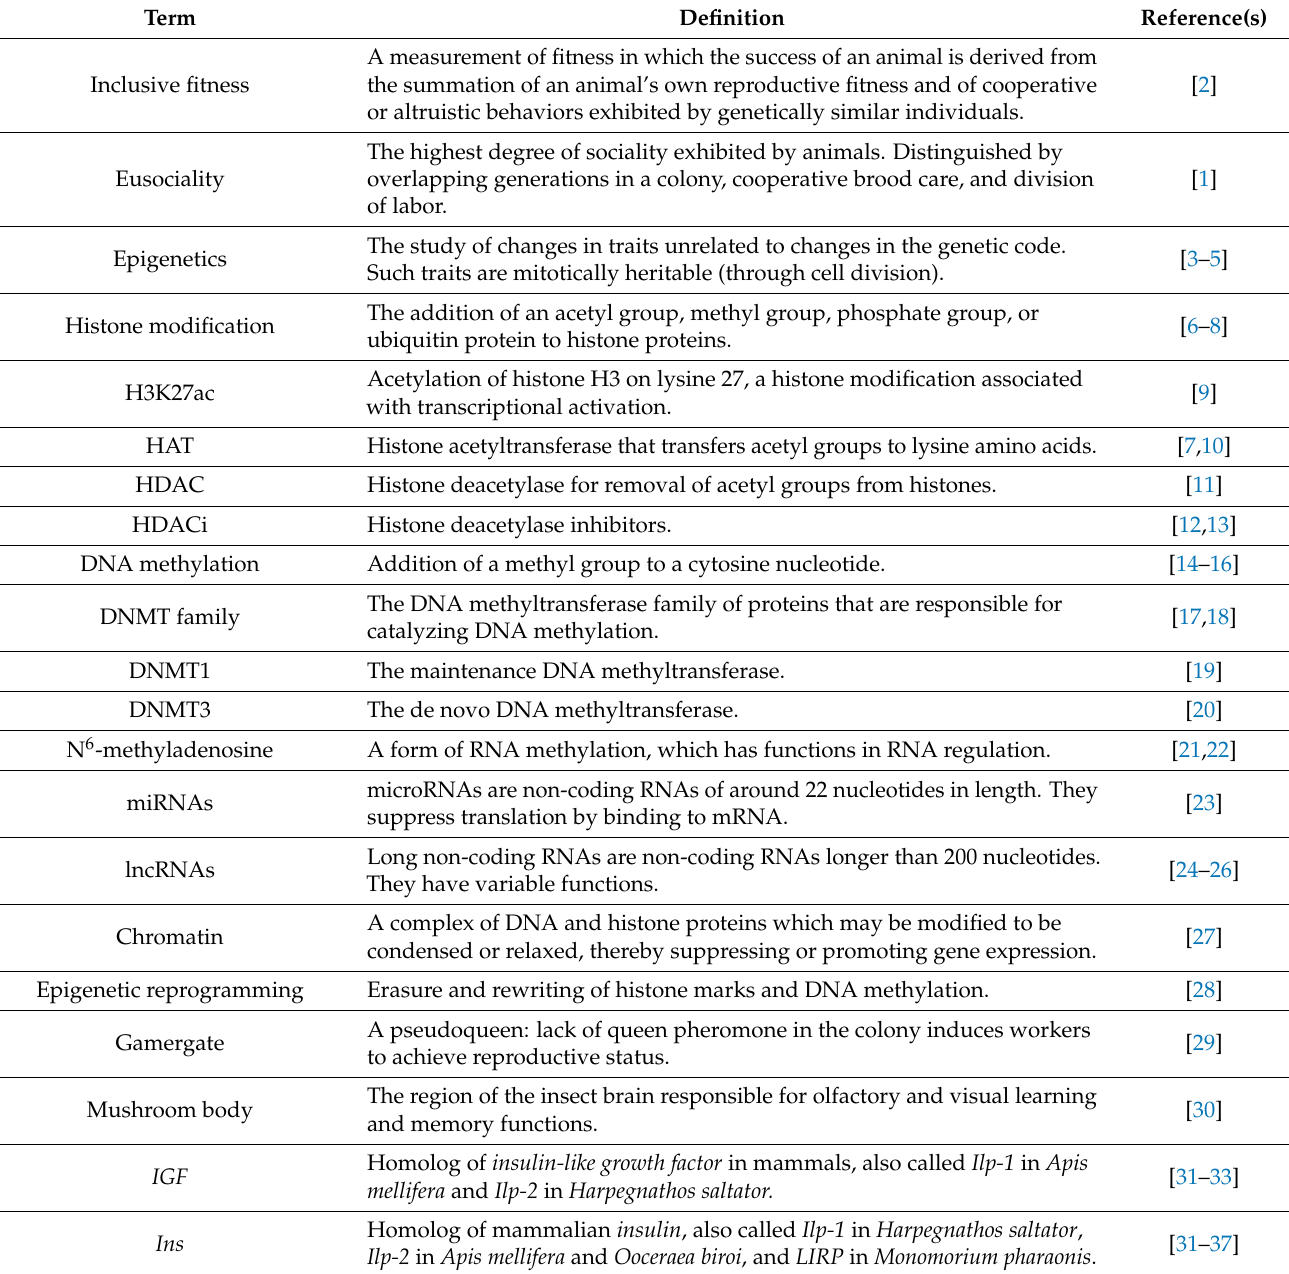
Table 1. Terminology associated with epigenetic study in eusocial